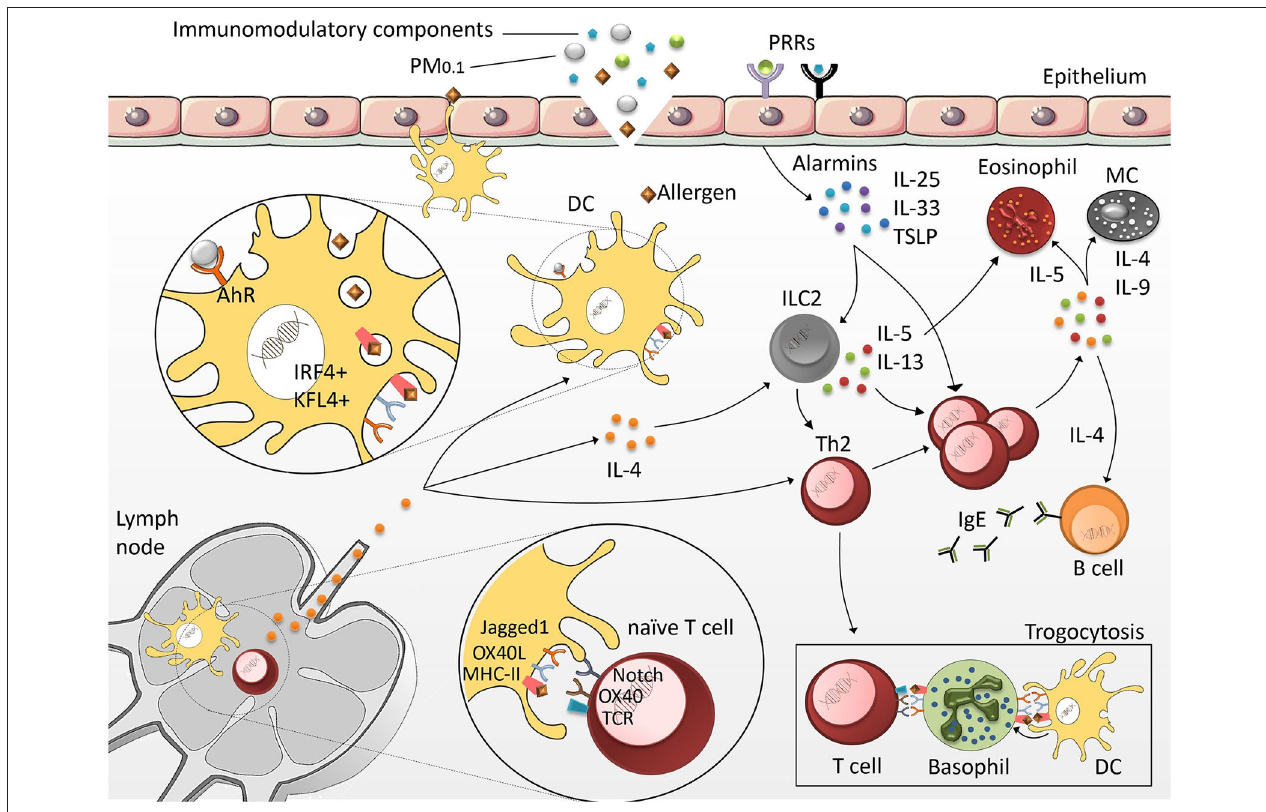
FIGURE 2 | Mechanisms of allergic sensitization. DCs located in the epithelia of peripheral tissues are exposed to allergens, immunomodulatory compounds and particulate matter (PM). Once activated, highly specialized CD11b + /CD301 + /PDL2 + /KFL4 + /IRF4 + DCs migrate into the lymph nodes to initiate the Th2 differentiation program. Upon exposure to epithelial-derived factors (IL-25, thymic stromal lymphopoietin (TSLP) and IL-33), group 2 innate lymphoid cells (ILC2) produce Th2 cytokines. This further promotes Th2 cell polarization and leads to exacerbation of the allergic response characterized by the secretion of IgE by B cells, and the activation of MCs and eosinophils. Basophils act as antigen-presenting cells (APCs) by presenting DC-derived antigenic peptides to T cells via a specific membrane transfer mechanism called